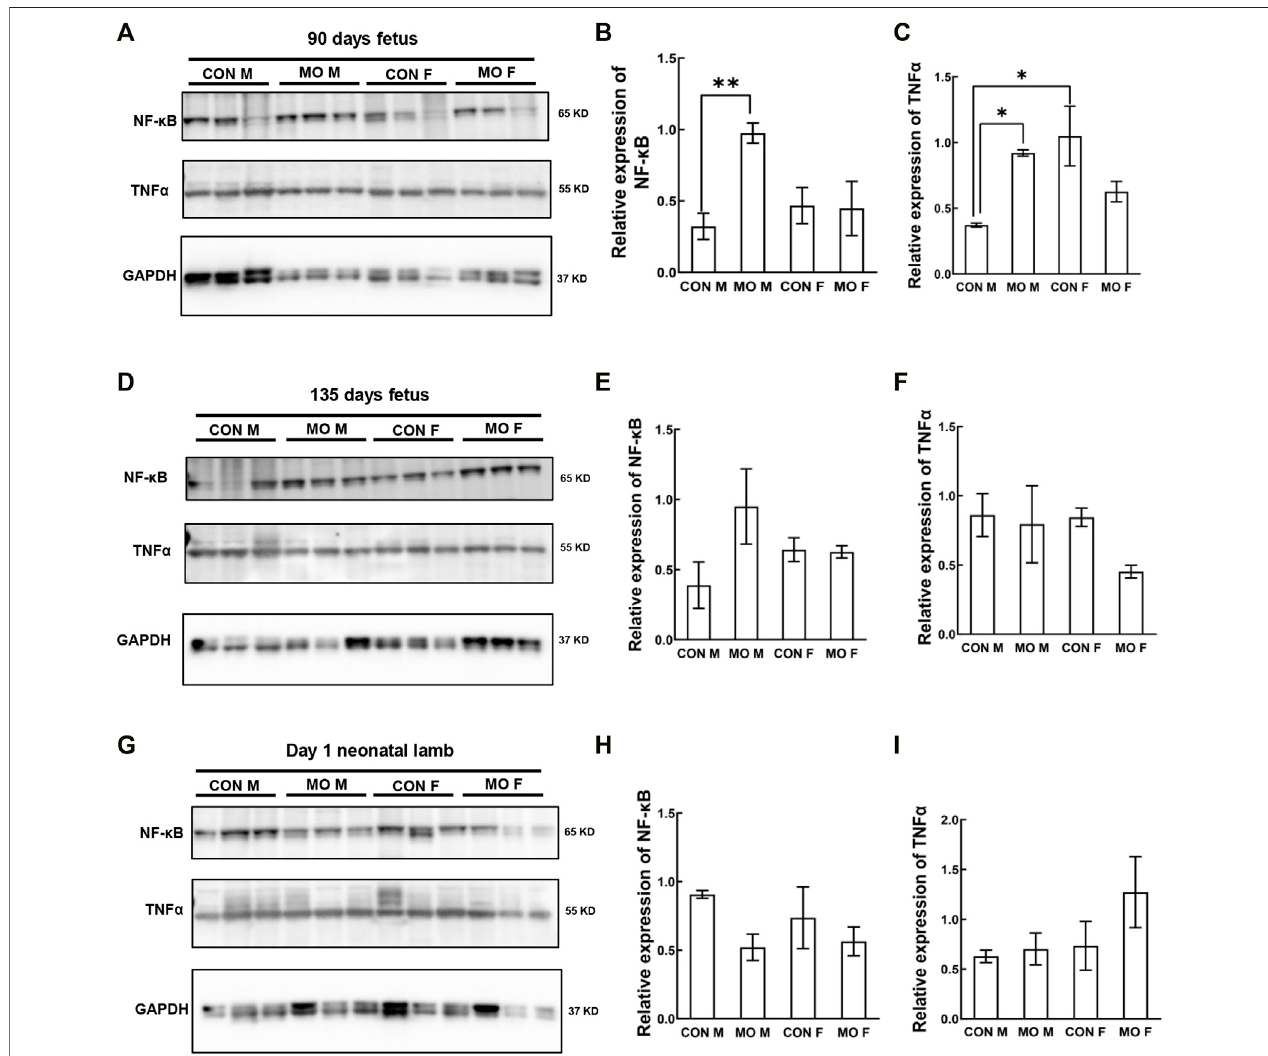
FIGURE 5 | Alteration of in fl ammatory cytokine NF- κ B and TNF α in offspring heart of overfed ewes at two gestational and one early postnatal time point. (A – C) . Relative expression level of in fl ammatory cytokine in fetal heart at mid-gestation day 90; (D – F) . Relative expression level of in fl ammatory cytokine in fetal heart at late- gestation day 135; (G – I) . Relative expression level of in fl ammatory cytokine in neonatal heart at day 1 after birth; GAPDH, Protein loading control. CON, control, MO, maternal obesity, M, male, and F, female. Mean ± SEM ( n (cid:1) 5); * p < 0.05, ** p <